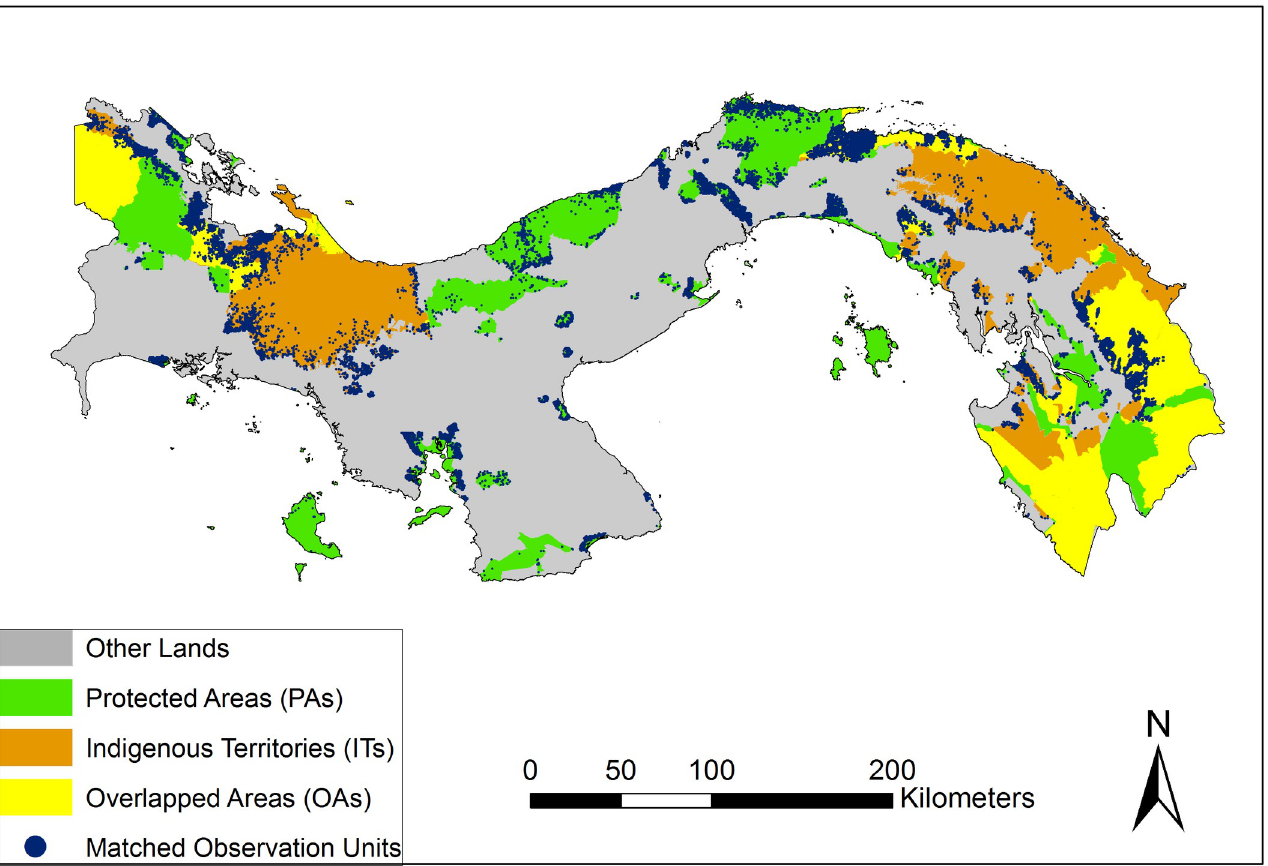
Fig 5. Observation units sampled through matching analysis in ITs, OAs, and PAs from